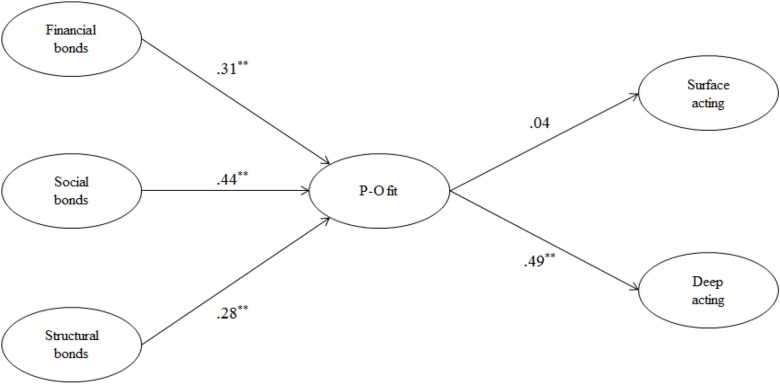
Results of hypotheses testing. (χ2 = 529.94, df = 201, p = 0.00, GFI = 0.88, CFI = 0.94, TLI = 0.93, NFI = 0.90, RMSEA = 0.07). ∗∗p < 0.01.